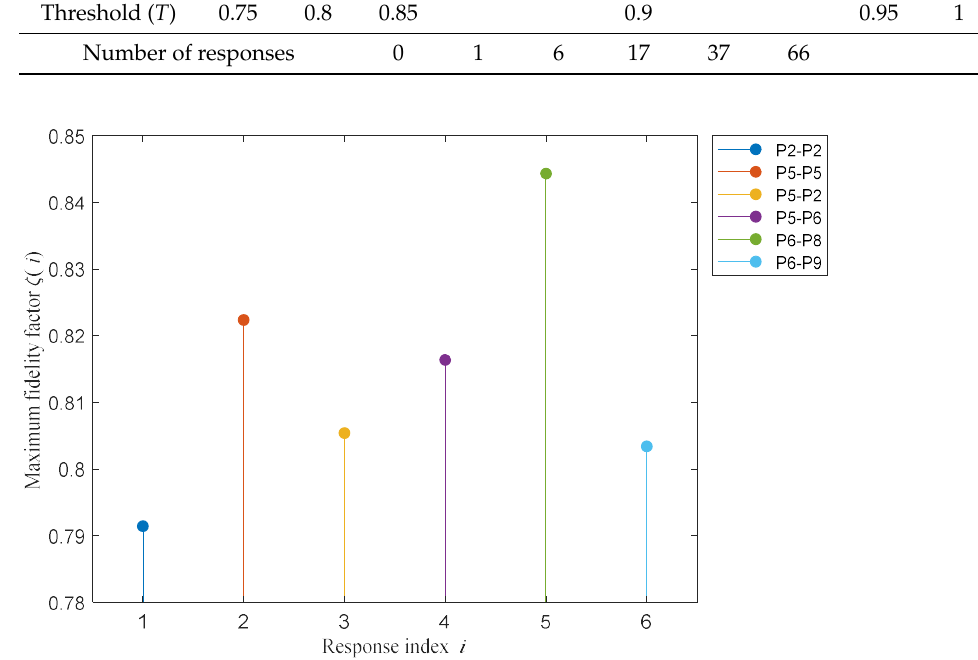
Figure 17. Responses that have maximum fidelity factor less than or equal to 0.85.